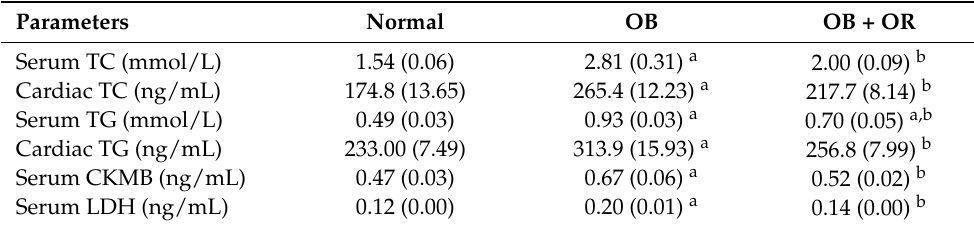
Table 2. Effect of orlistat on lipid components and cardiac enzymes in obese rats.